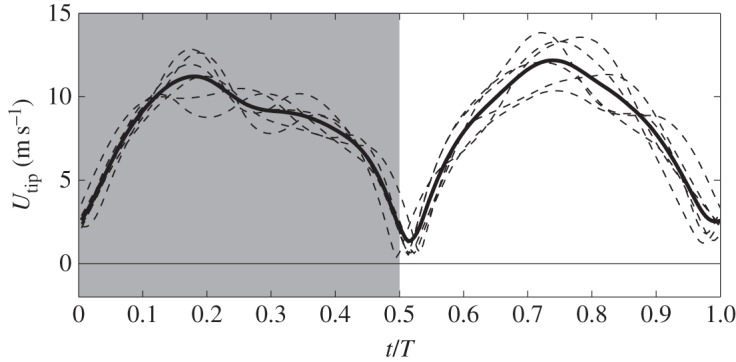
Instantaneous (thin dashed lines) and average (thick line) wingtip velocity. In all figures, grey background represents downstroke and white represents upstroke.